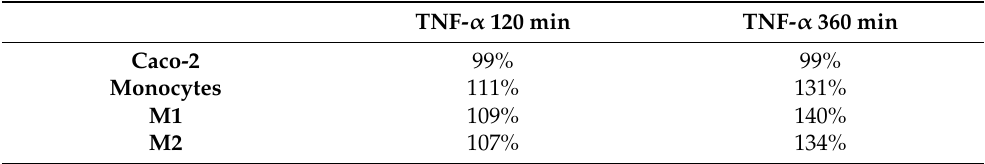
Table 1. Change of ASMase activity (U/mL) in cell supernatant after 120 min and 360 min treatment of 50 ng/mL TNF- α